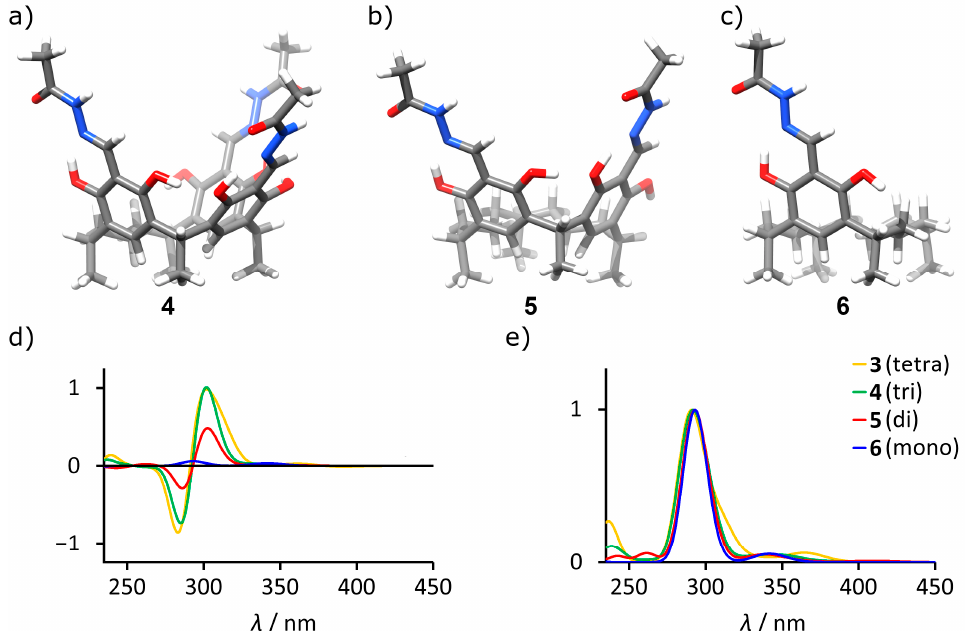
Figure 4. The influence of the number of units on the ECD spectra theoretical calculations (TD DFT B3LYP/6-31G(d,p)). ( a – c ) Models used for estimation of the influence of the number of units (coordinates available in Supplementary Materials); ( d ) calculated ECD spectra; ( e ) calculated UV spectra. The intensities of theoretical spectra were normalized at the intensity of UV spectra of ( M, s-trans, s-cis )- 3 .